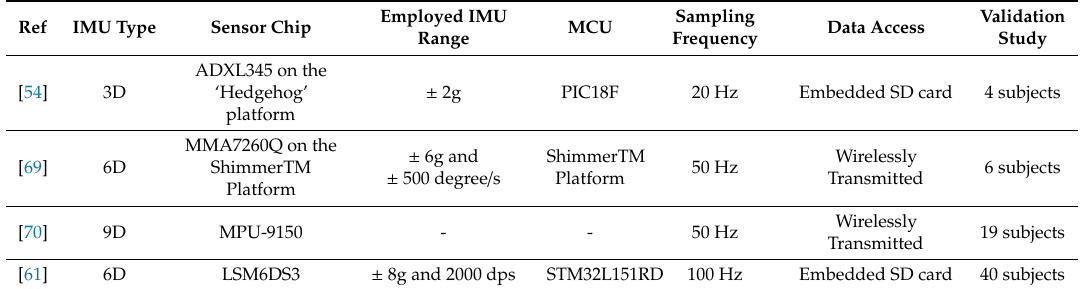
Table 6. Comparison of Inertial sensors employed in smoking research. IMU = Inertial Measurement